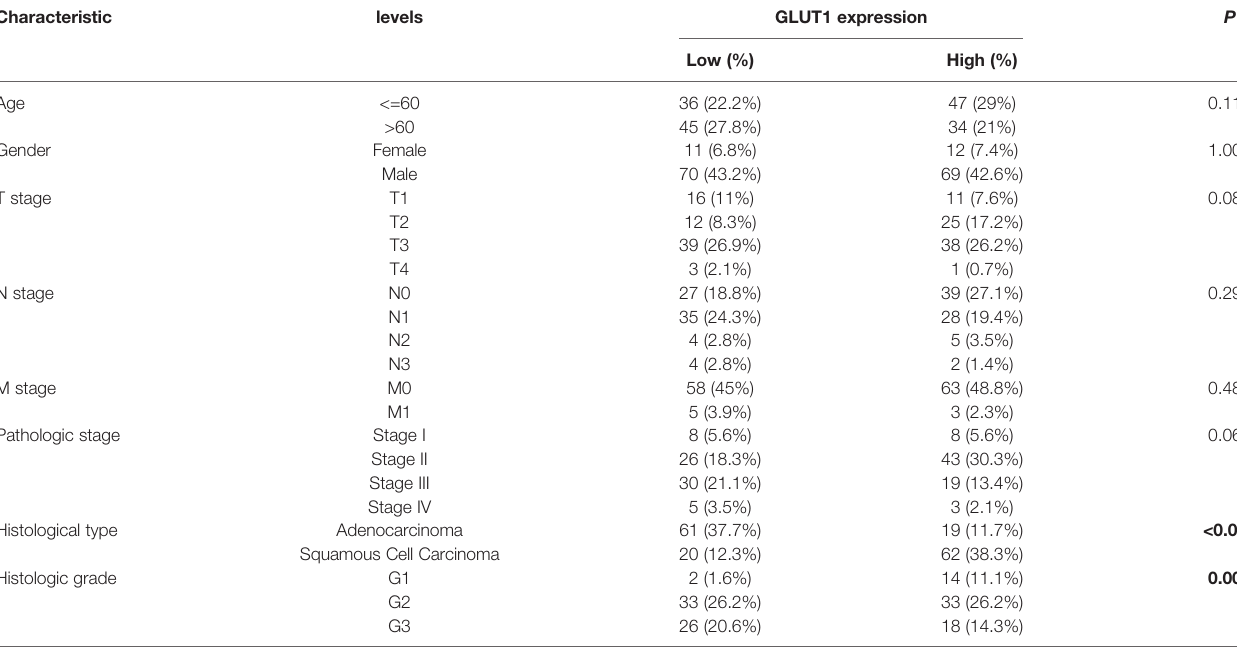
TABLE 1 | Correlation of GLUT1 mRNA expression with clinicopathological features in the TCGA cohort.